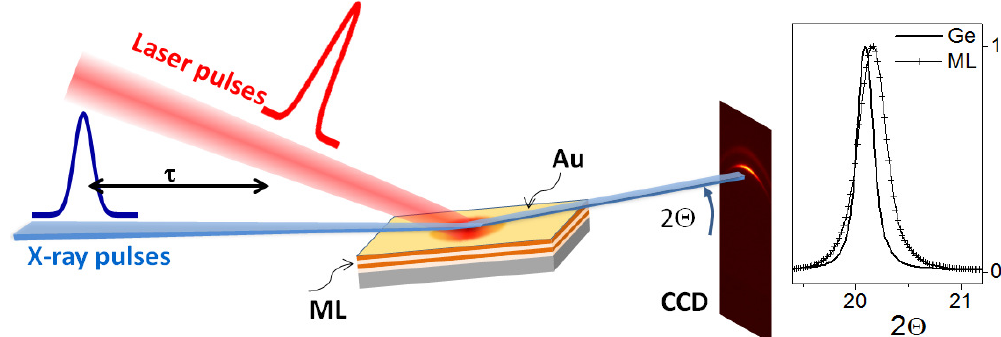
Figure 2. ( Left ) scheme of the laser pump, X-ray probe setup for the determination of cooling kinetics with 100 ps time resolution at a 3rd generation synchrotron. The train of X-ray and laser pulses are overlapped on the wafer surface with a defined delay τ between the pulses. Powder scattering is recorded on a CCD detector. Its angular deviation 2 Θ ( τ ) serves as temperature monitor of the gold cover layer. ( Right ) Comparison of radial powder lines of the (111) reflection of gold in monochromatic X-ray mode (Ge monochromator) and in broad band mode (multilayer